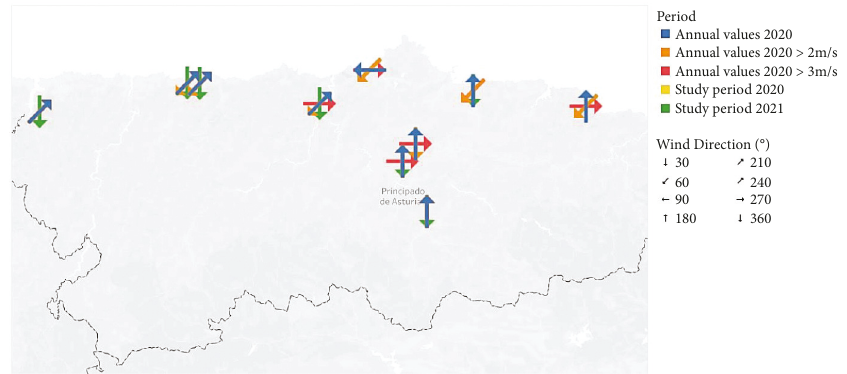
Figure 6: Prevailing wind directions at different sampling sites and